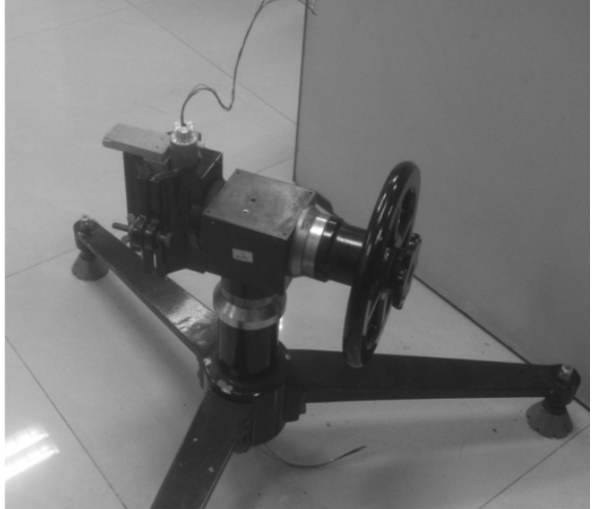
Figure 8. The calibration and experiment platform.